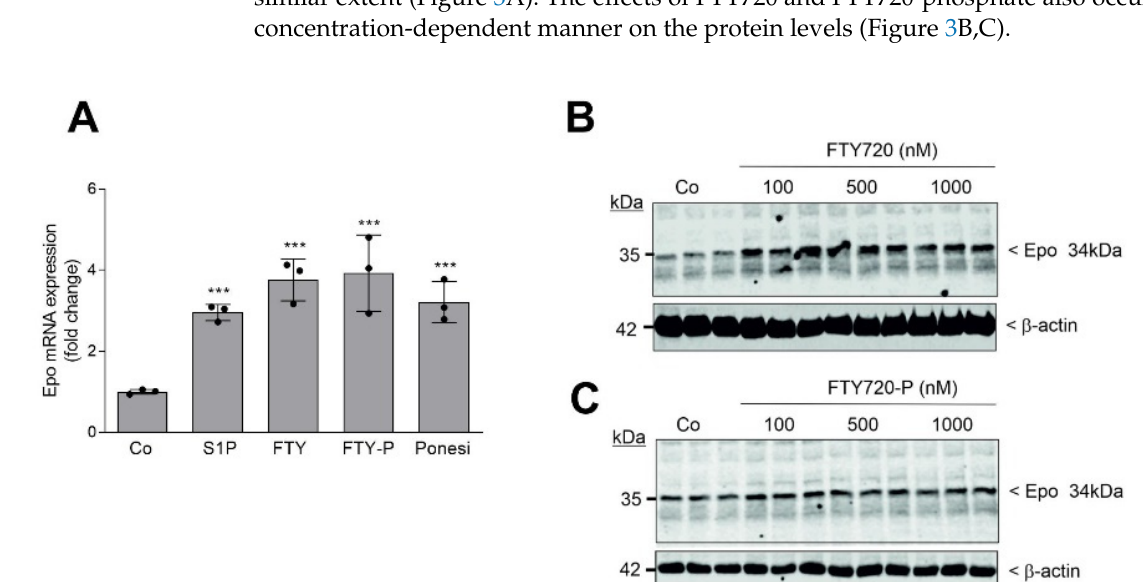
Figure 3. Effect of FTY720 and FTY720-phosphate on mouse Epo mRNA and protein expression in F3-5 cells. ( A ) Confluent and quiescent F3-5 cells were stimulation for 6 h with either vehicle (Co) or 1 µ M of S1P, FTY720 (FTY), FTY720-phosphate (FTY-P), and ponesimod (Ponesi). RNA extracts were prepared and taken for quantitative PCR analysis using primers of mouse Epo, and mL28 for equalization. ∆∆ Ct values were calculated as fold change compared with the control and are means ± S.D. ( n = 3), *** p < 0.001 was considered statistically significant when compared with the control. ( B , C ) Quiescent cells were stimulated for 6 h with either vehicle (Co) or the indicated concentrations of FTY720 ( B ) and FTY720-P (C). Thereafter, protein extracts were prepared and separated by SDS-PAGE, transferred to nitrocellulose membranes, and subjected to Western blot analyses using antibodies against mouse Epo and β -actin. Bands corresponding to Epo and β -actin were evaluated by Image Studio Lite software and the results are depicted in Supplementary Figure S3.